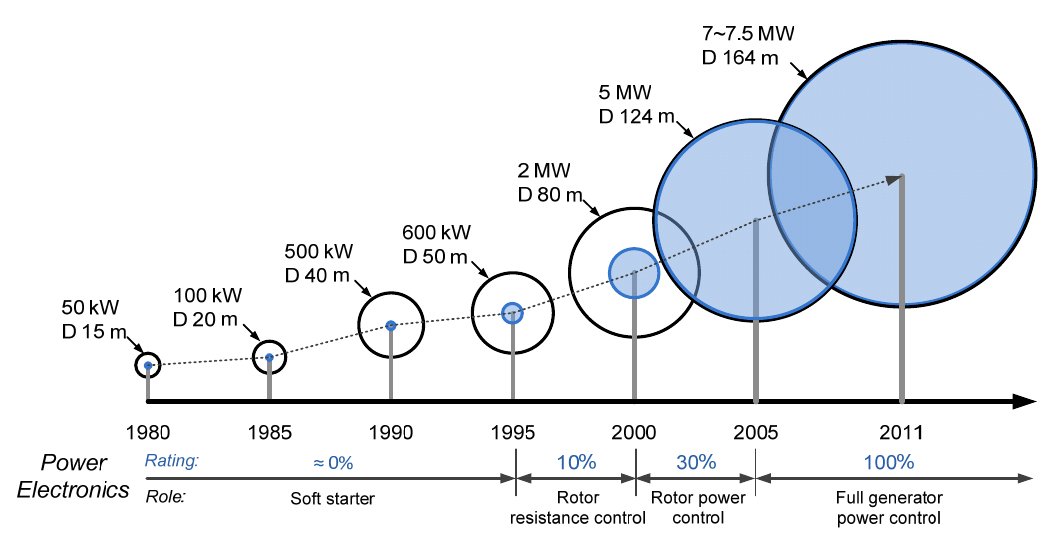
Figure 1. Evolution of wind turbines and power converters in the last 30 years (blue color indicates power level of converters in proportion to the wind turbines)